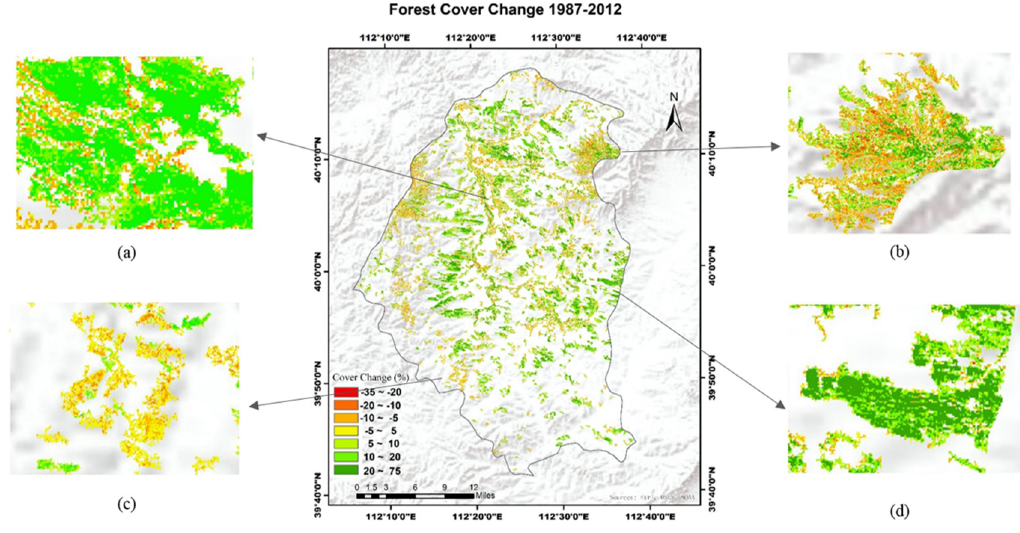
Figure 6. Forest cover change from 1987 to 2012.( a ) Plantation area with forest cover increases; ( b ) native forest; ( c ) plantation area with unchanged forest cover; and ( d ) plantation area.